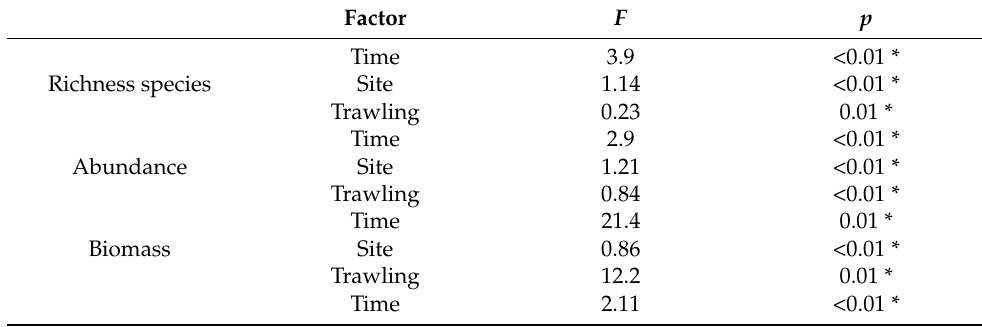
respectively) (Table 3), with higher values of these indices corresponding to control sta- tions during the lockdown period (H’= 3.6 bits.ind − 1 ; J’= 0.95 in C2) (Figure 4). Table 3. Results of the ANOVAs with the three factors: time (5 levels; df = 4), trawling (2 levels; df = 1), and site (4 levels; df = 3) for the five biological variables (*: significant variation).